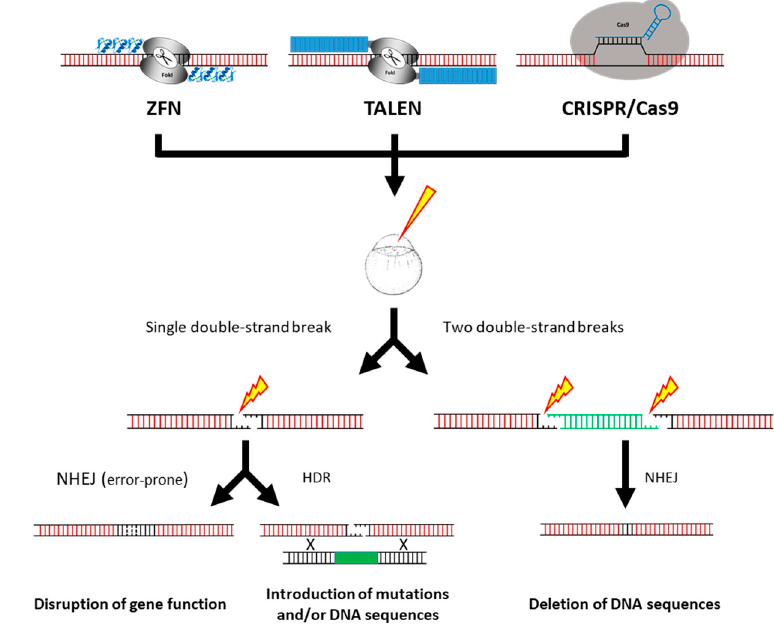
Figure 3. Gene targeting using programmable site-specific endonucleases. RNAs and / or proteins corresponding to the components of the ZFNs, TALENs and CRISPR / Cas9 programmable site-specific endonuclease systems are injected into zebrafish embryos at the 1-cell stage to induce double-strand DNA breaks at the target genomic sites. Cellular DNA repair mechanisms including non-homologous end joining (NHEJ) and homology-directed repair (HDR) are responsible for gene editing events such as the disruption of gene function, gene deletion or the introduction of precise modifications.